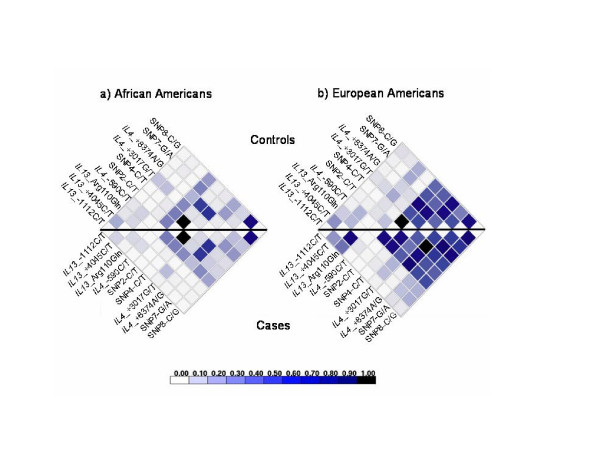
Pairwise LD plots (r2) for cases (lower half) and controls (upper half) in a) African Americans and b) European Americans.